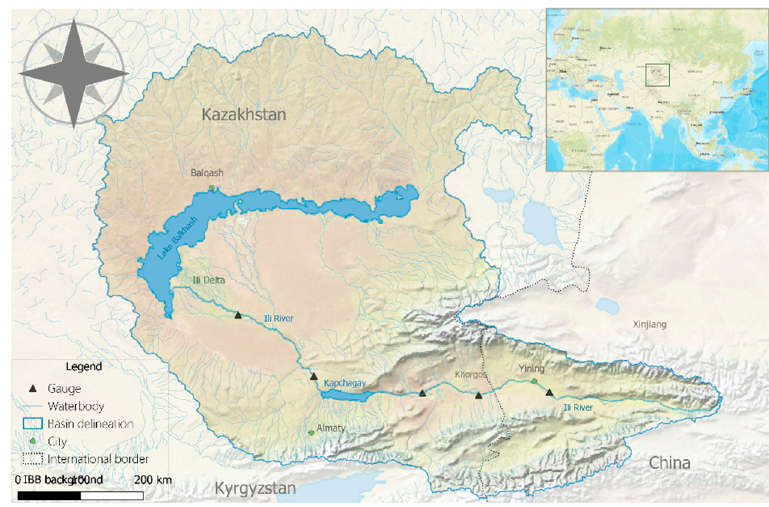
Figure 1. Map of the Ili-Balkhash Basin.